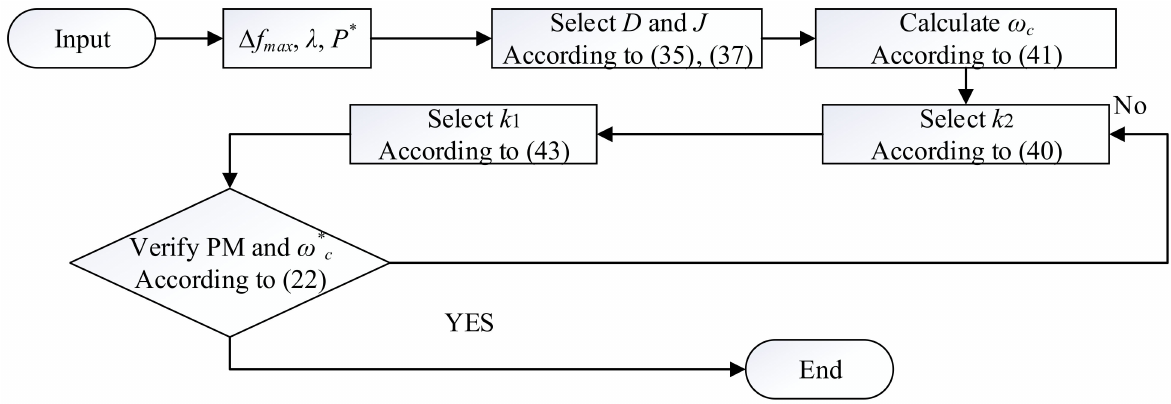
Figure 15. Parameter design flow.